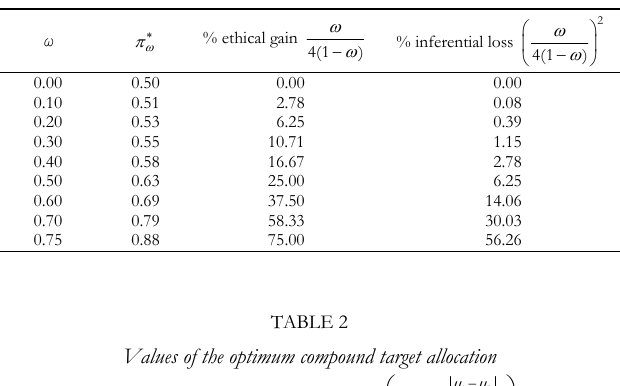
Values of the optimum compound target allocation  in (8) with ethical  